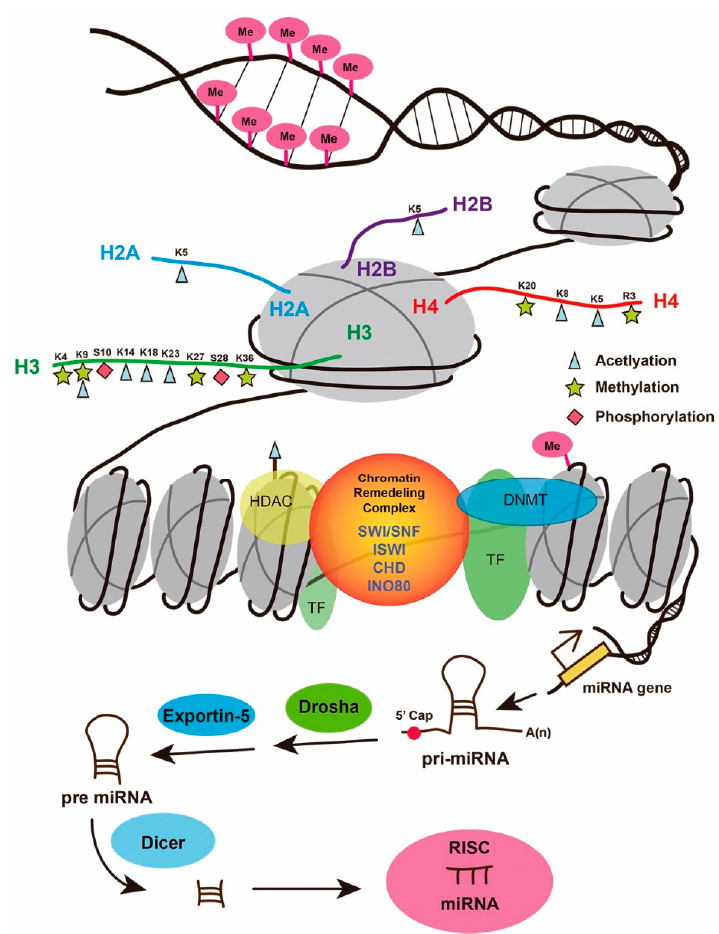
Figure 1. Schematic illustration of epigenetic regulation. Epigenetic regulation mainly comprises DNA methylation, histone modifications, chromatin remodeling complexes, and non-coding